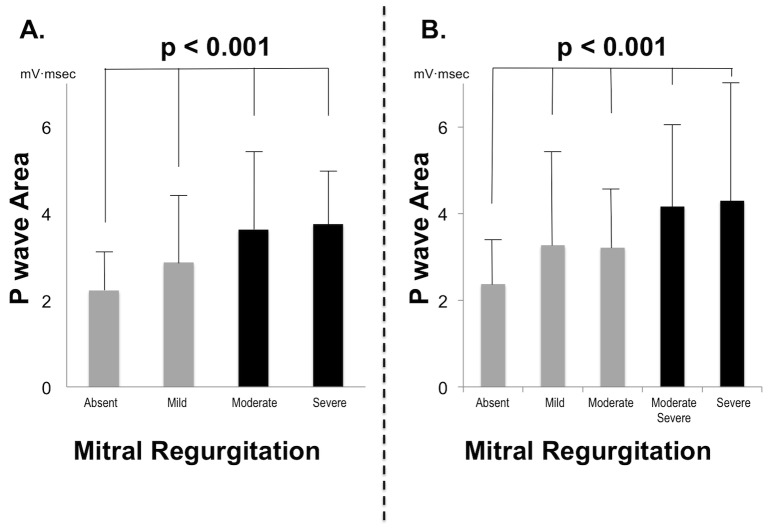
Mitral Regurgitation Severity.P wave area in lead V1 (mean ± standard deviation) in relation to MR severity on cine-CMR (3A) and echo (3B). Note that P wave area increased stepwise in relation to MR severity as measured by both modalities, with greatest magnitude of increase at a threshold of moderate-severe MR (black bars).